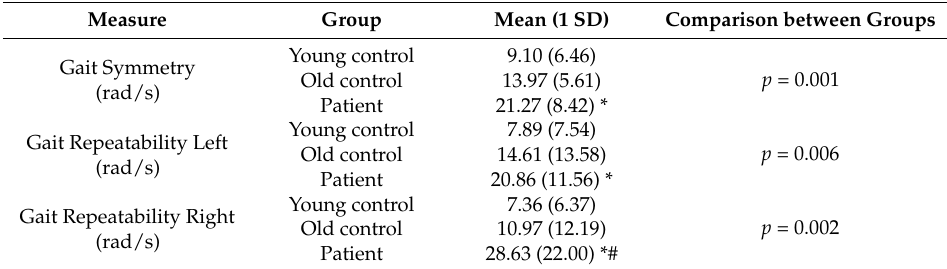
Table 5. Group comparison of gait regularity variables with the eyes closed